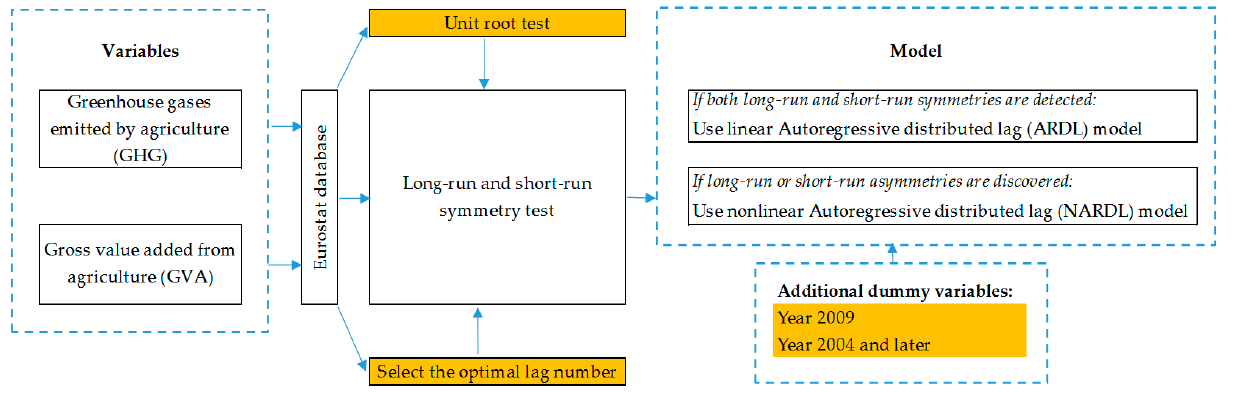
Figure 1. Framework of the research.